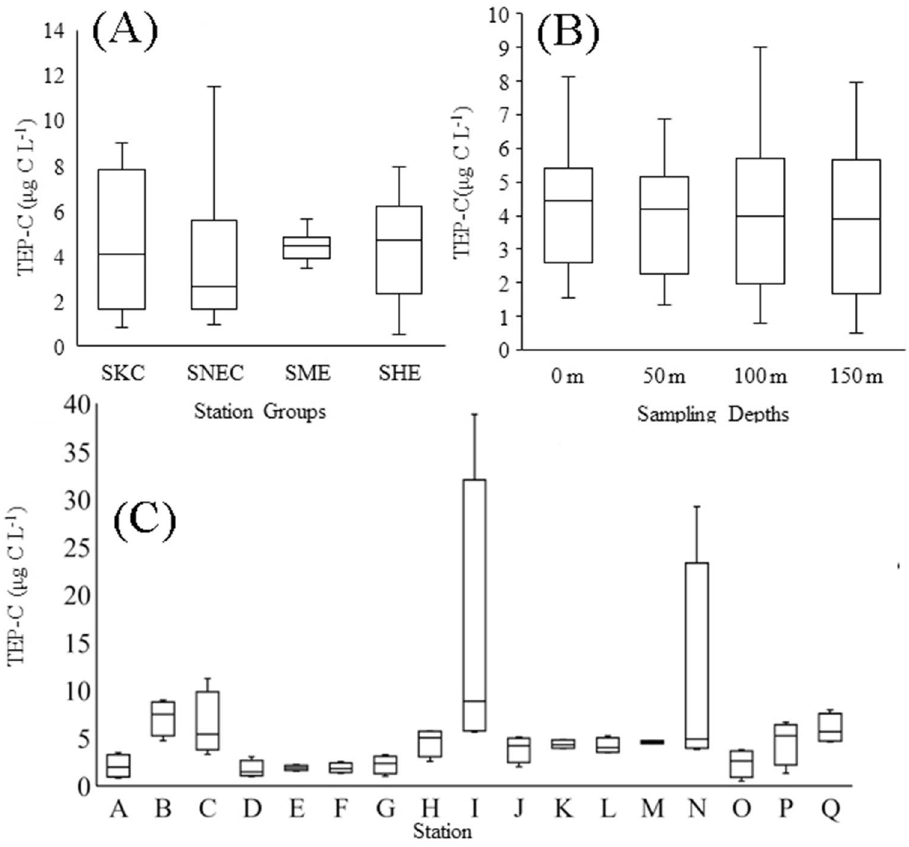
Figure 5. Average variations in TEP C concentrations at all water depths ( A ) and sections ( B ) and at each sampling station ( C ) in the WPO.